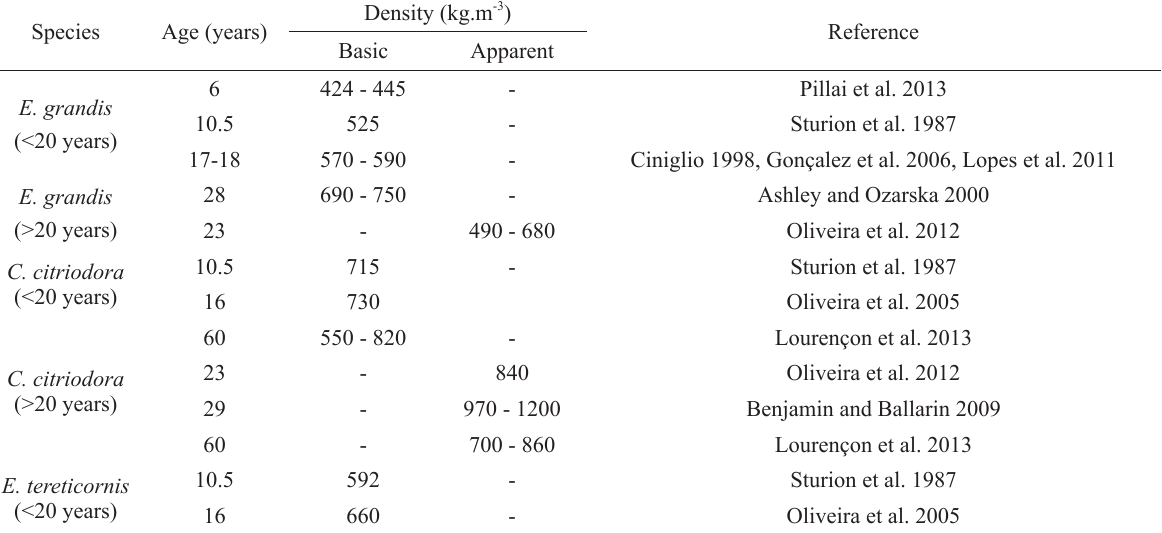
Summary table - density values reported in the literature for E. grandis, E. tereticornis and C. citriodora .